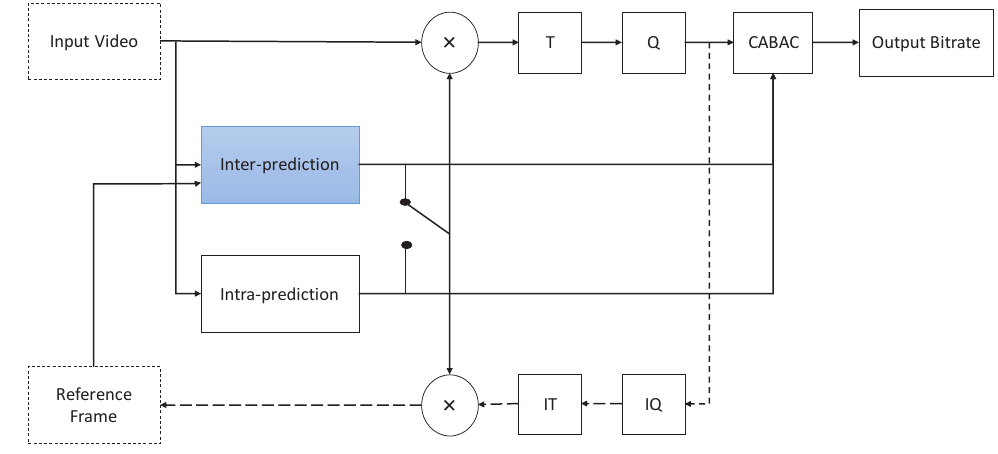
Figure 1. The structure of high efficiency video coding (HEVC, or H.265) encoder.